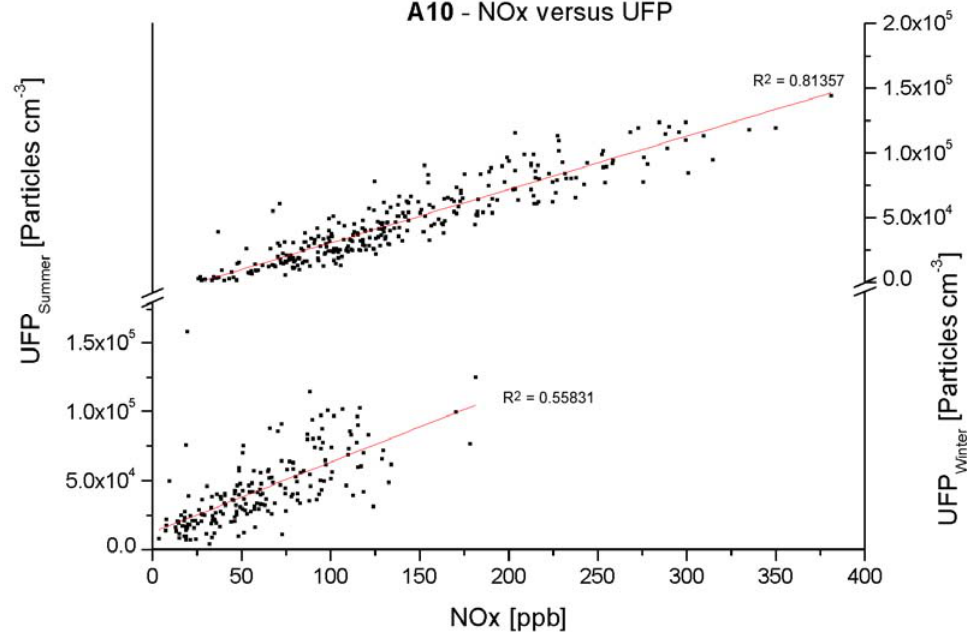
Figure 4. Scatter-plots of environmental factor NO shown: UFP/NO at motorway A10 in summer (lower section) and winter (upper section). X